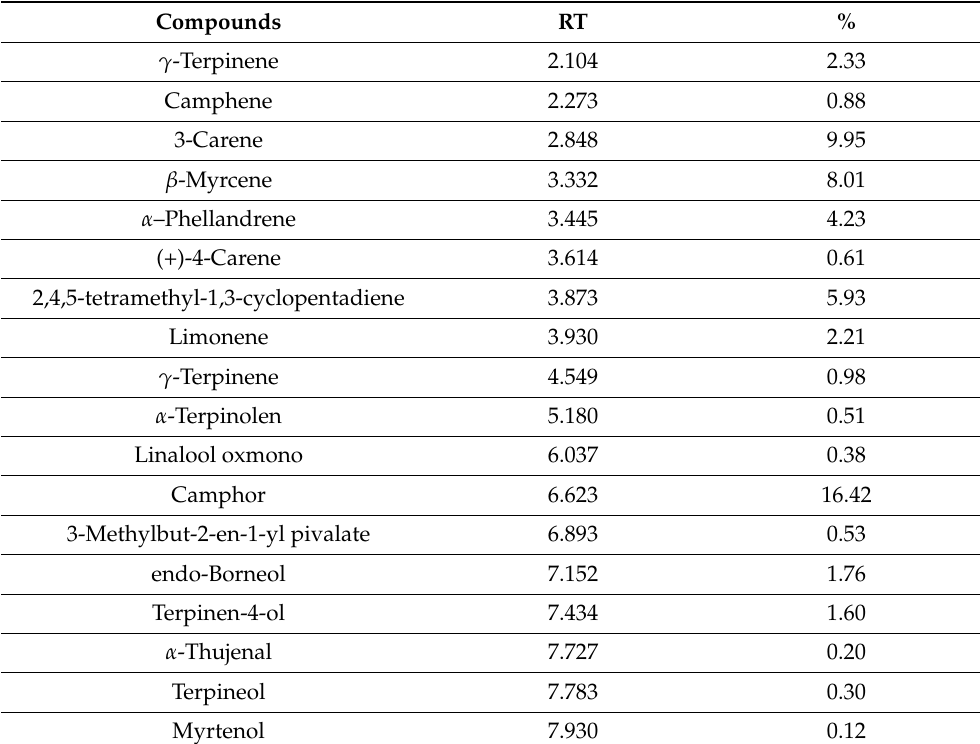
Table 2. Chemical composition of MCEO.